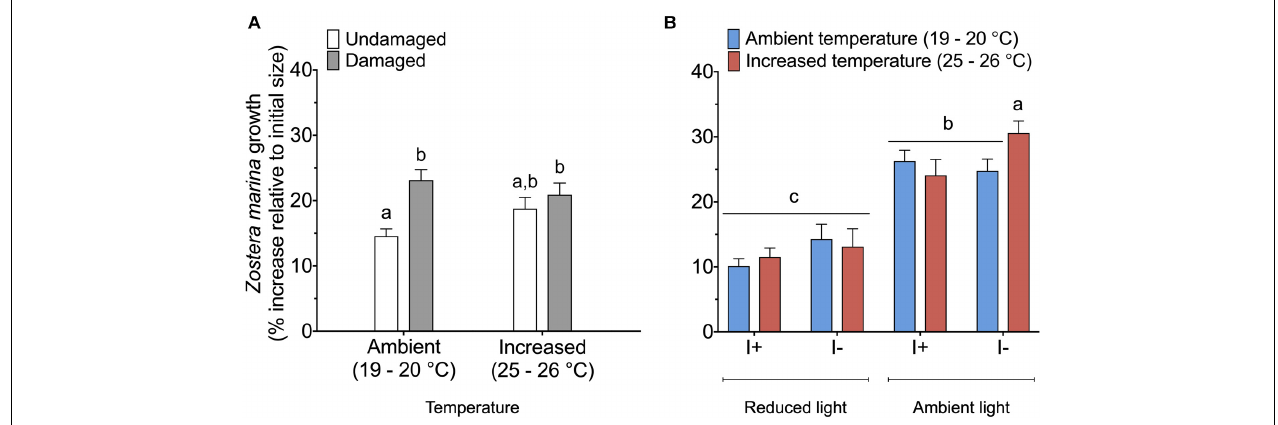
FIGURE 4 | Growth (% increase relative to initial size) of Zostera marina exposed to (A) ambient or increased temperature, and damaged or undamaged tissue ( n = 80), and (B) ambient or increased temperature, ambient or reduced light, and inoculation or non-inoculation of Labyrinthula zosterae ( n = 40). I+ = inoculated, I– = non-inoculated. Different letters above bars indicate significant difference between treatments based on the Student–Newman–Keuls test ( P < 0.05). Only significant results (see Table 3 ) are included in the figures and not all interactions. The non-significant treatments are therefore pooled giving a higher replication than 20 replicates per treatment. Error bars show standard error.